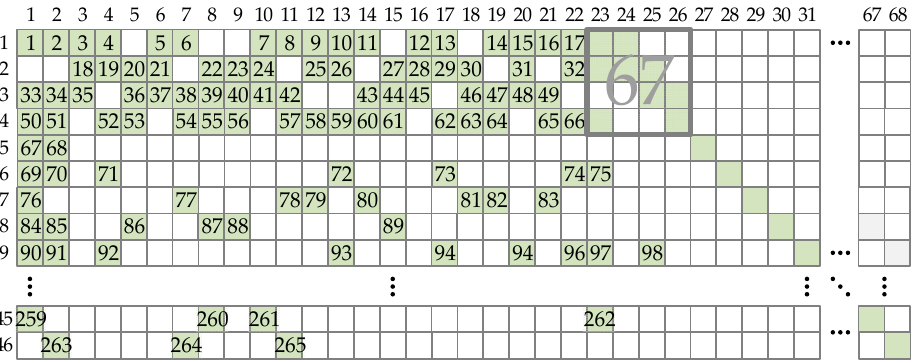
Figure 2. Encoding schedule for BG1 codes when serially processing single CPM at a time. Numbers represent the ordinal of the clock cycle in which the corresponding CPM is processed.